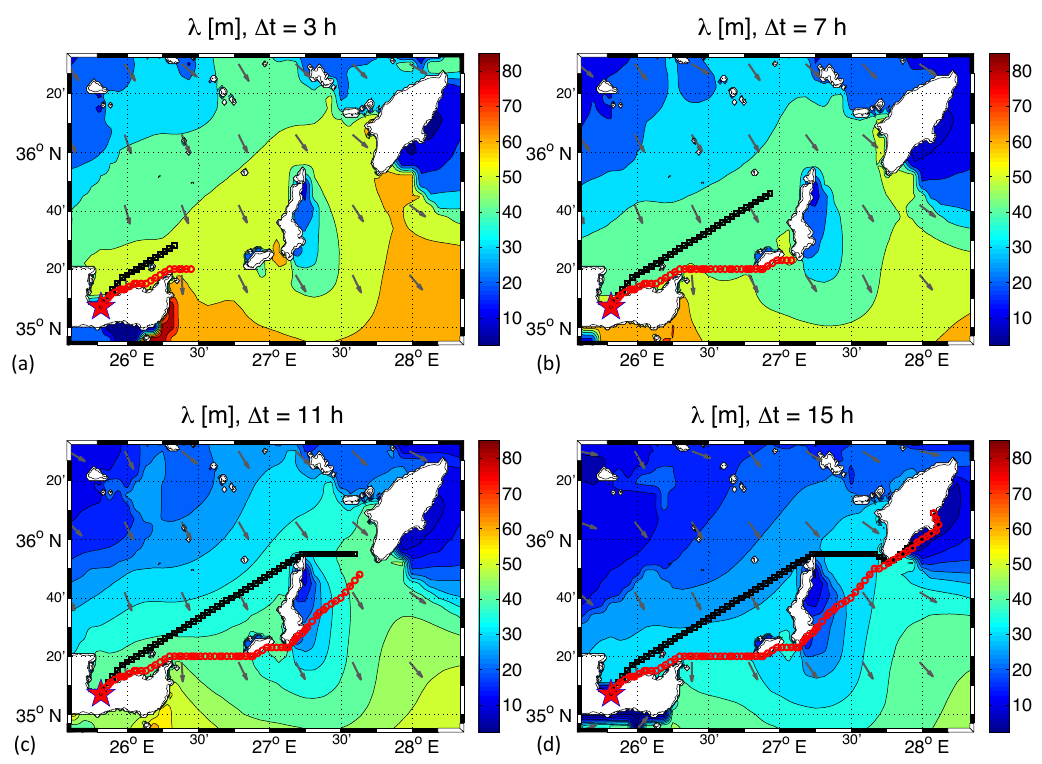
Figure 12. Case study #2. Geodetic (black markers) and optimal (red markers) route from Crete to Rhodes (Greece) for vessel V2 of Table 5 and departure on 20 September 2014 at 20:00UTC. Panels (a–d) refer respectively to timesteps #4, 8, 12, and 16 after departure. Wavelength analysis fields λ are displayed with coloured shadings and wave directions are displayed with arrows. Animation of the route is provided at http://dx.doi.org/10.5446/18088.